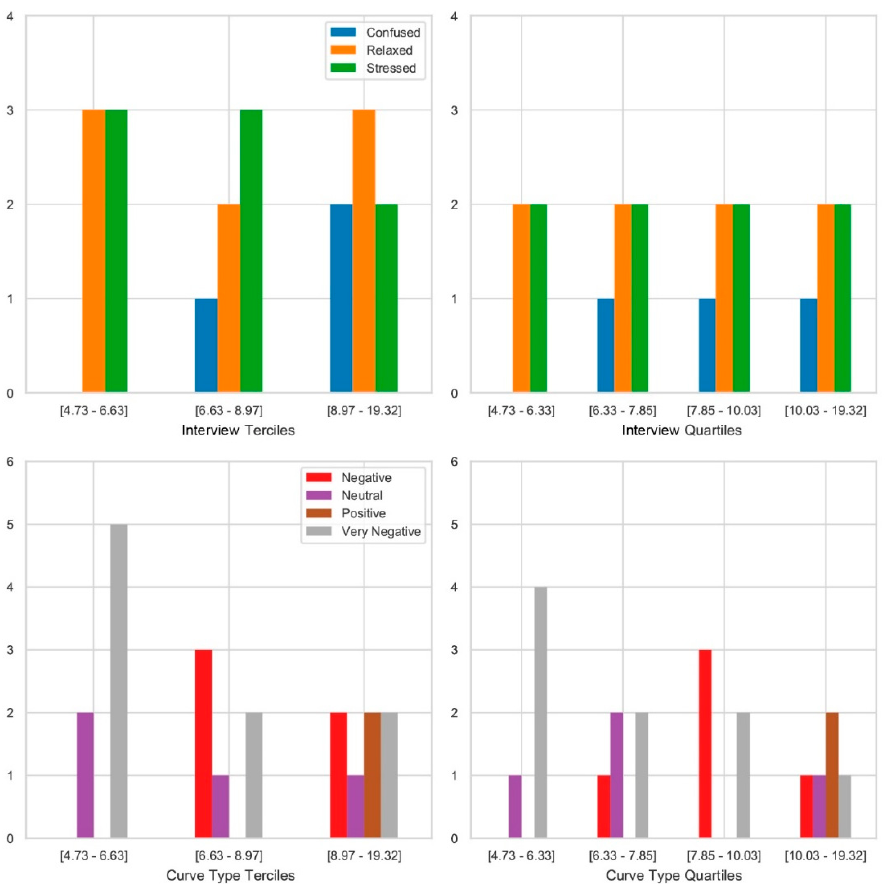
Figure 6. Quantile-based approach. The top row shows clusters of the groups from the interview data and the bottom row shows clusters of the curve types. Terciles are shown to the left and quartiles to the right. The x-axis shows clusters and their ranges in seconds and the y-axis shows how many participants each cluster is populated